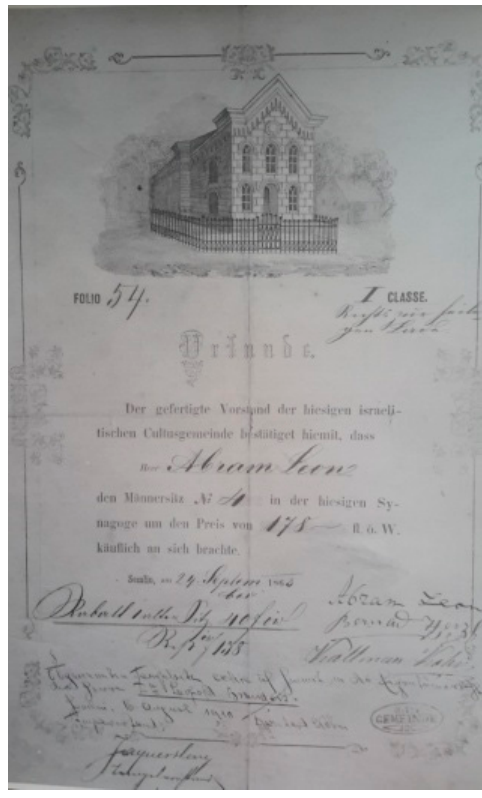
Figure 8. Receipt showing that Leon Abram bought the right to sit in the second row of the men’s section of the synagogue in 1863.